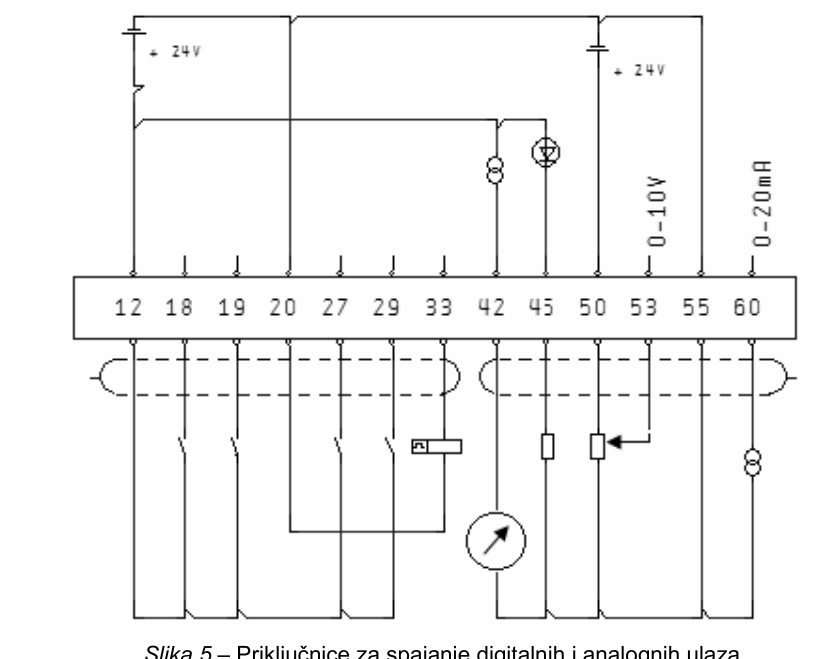
Figure 5 – Jacks for connecting digital and analog